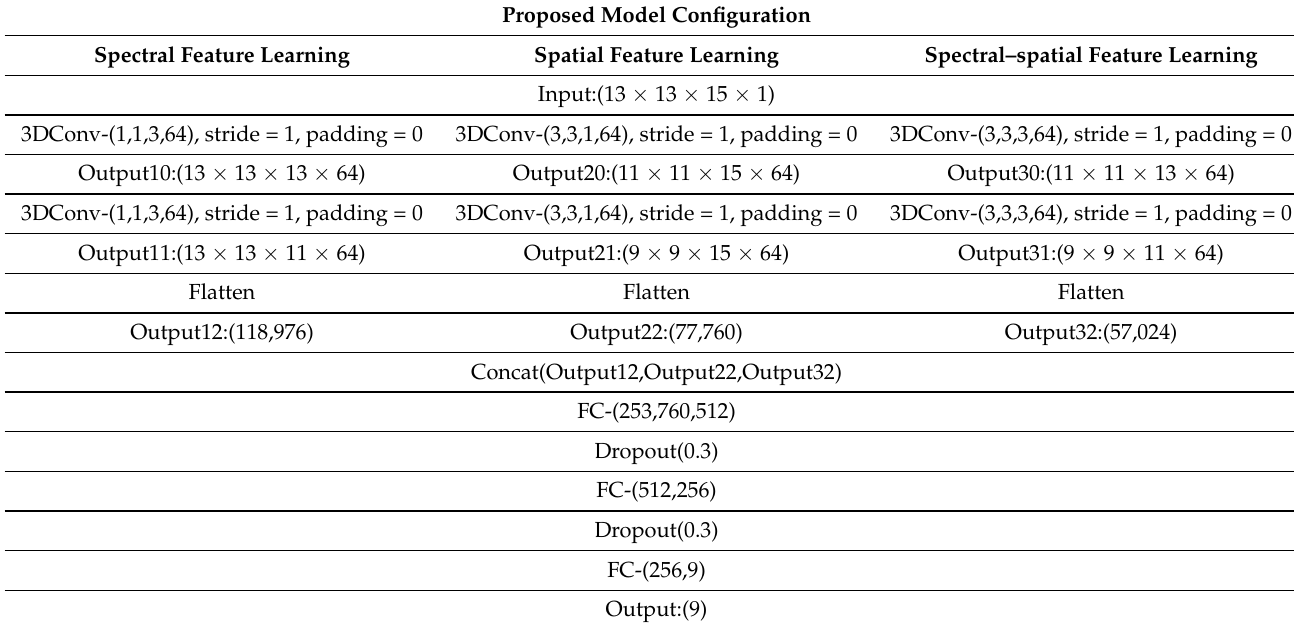
Table 4. The network configuration for the proposed model on the Pavia University